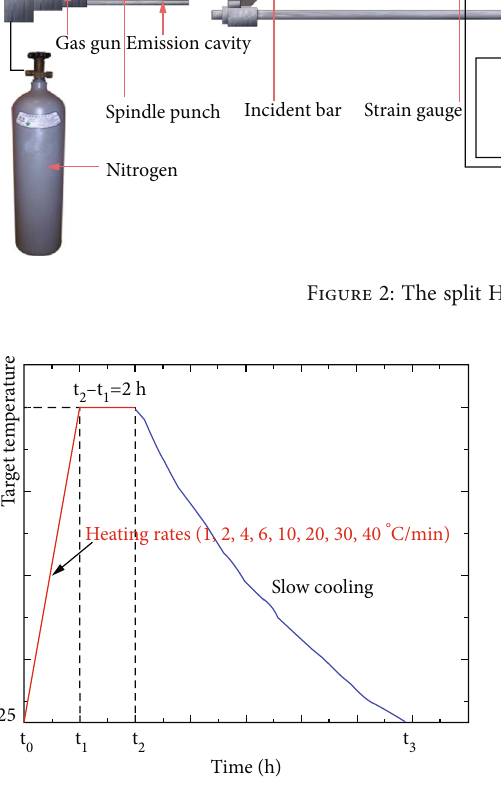
Figure 3: The heating and cooling